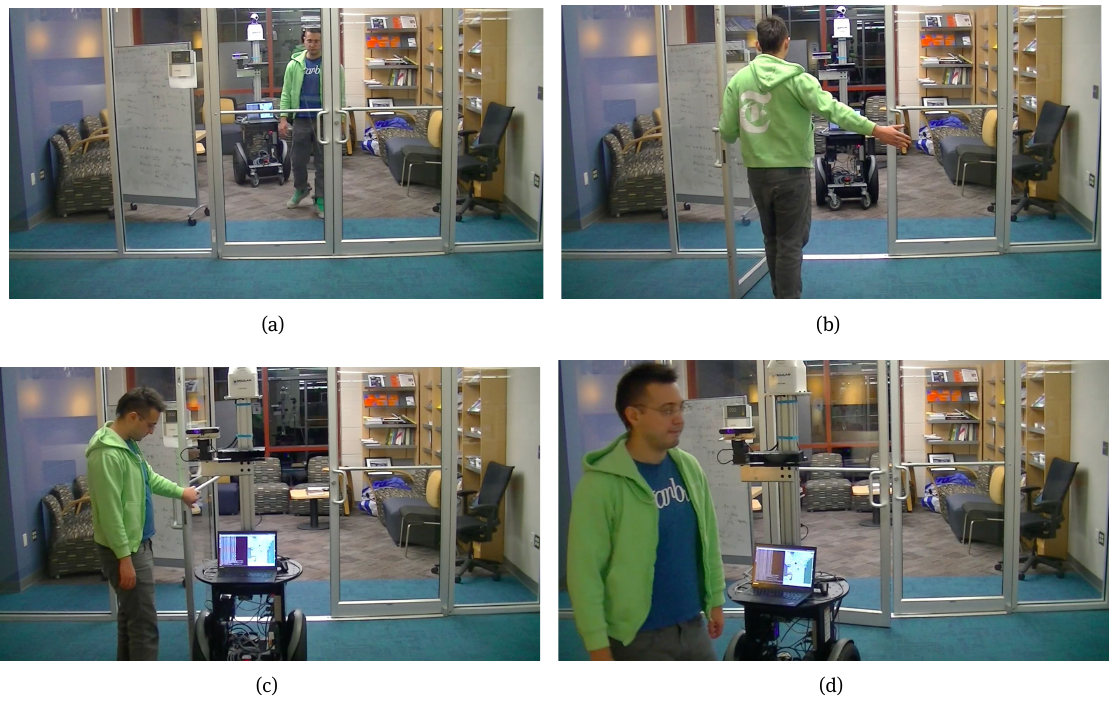
Figure 16: Demonstration of context-awareness for door passing during person following. This is a swing door with spring loaded hinges, so it would close if not kept open actively. a) The robot is following the user by keeping a fixed distance to the user; b) Signal Phase: The user has stopped, is in close proximity to the door and performed a pointing gesture toward the other room; c) Approach Phase: The robot passes the door while the user is holding the door; d) Release Phase: The user has more than a threshold distance to the door, and the robot continues with the basic following. Table 4: Conditions to trigger phases when the user is passing through a door during